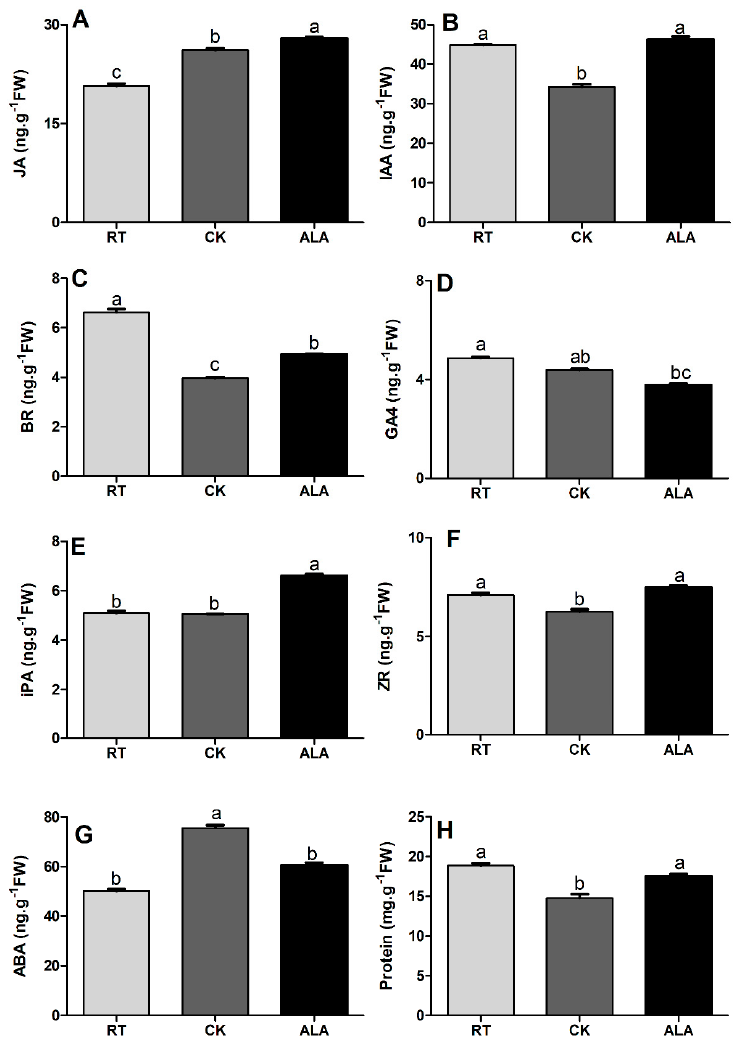
Figure 7. Effect of ALA on endogenous hormone accumulation under low-temperature stress conditions. A ; Jasmonic Acid, B ; Indole acetic acid, C ; Brassinosteroid, D ; Gibberellic Acid, E ; Indole-3-propionic Acid, F ; Zeatin riboside, G ; Abscisic Acid, and H ; Protein. RT= regular temperature; CK = control; ALA = 30 mg/L ALA. Different letters indicate a significant difference at p < 0.05.